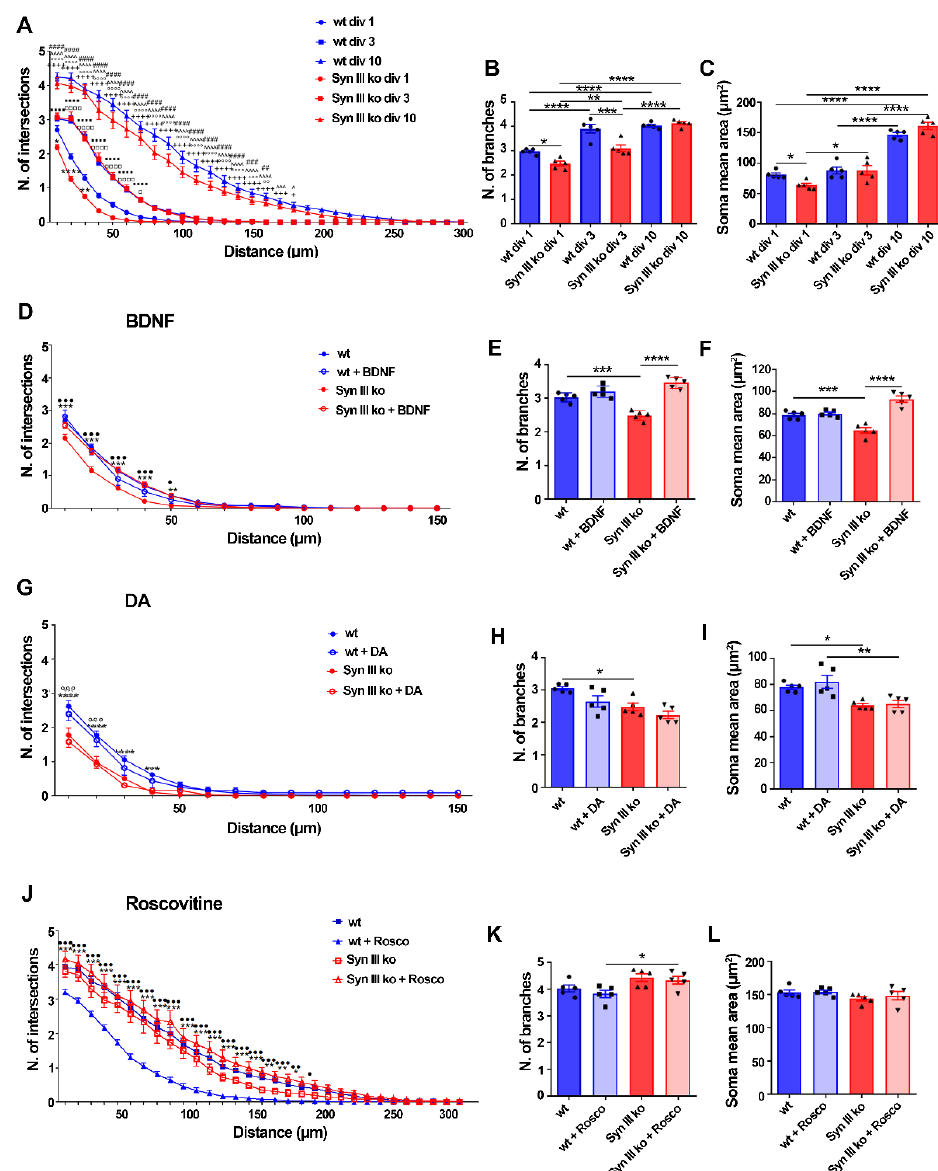
Figure 6. Syn III ko TH-positive mesencephalic neurons exhibit neurodevelopmental deficits involv- ing BDNF and Cdk5 signaling. ( A , D , G , J ) Sholl analysis assessing the number of intersections. ( A